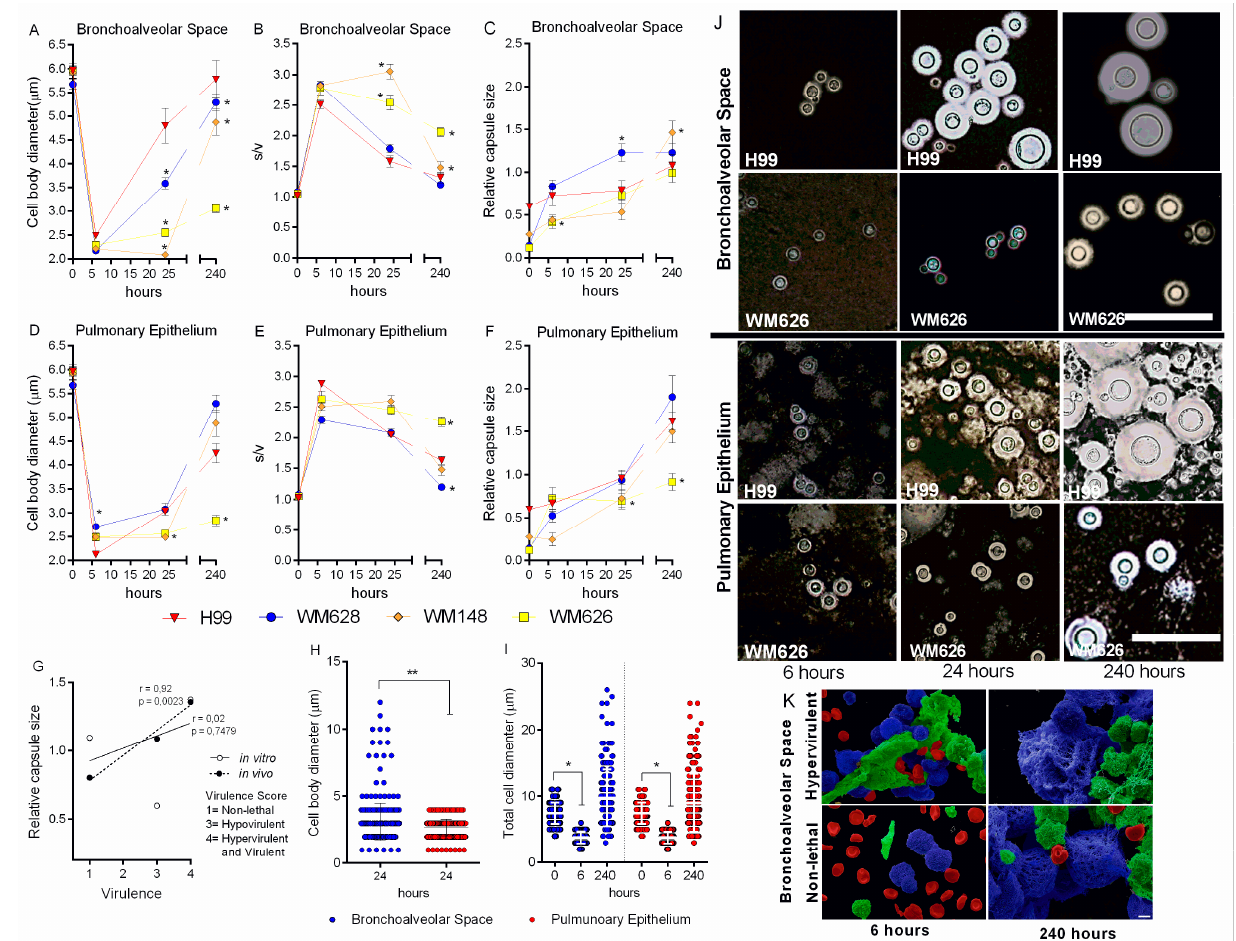
Figure 3. Dynamics of morphological variation of C. neoformans in vivo. ( A – F ) Morphological variation in bronchoalveolar space (BS) and pulmonary epithelium (PE) of four strains of C. neoformans after 6, 24, and 240 h of intratracheal infection. Mean values were compared with H99 (* p < 0.05). ( G ) Correlation between virulence and relative capsule size after 240 h infection. R values are included next to lines of best fit and are based on Pearson correlation. ( H ) Cell body diameter in BS and PE after 24 h of infection. Mean values were compared with bronchoalveolar space (** p < 0.01). ( I ) Total cell diameter in BS and PE after 0 and 240 h infection. Mean values were compared with 0 h of infection (* p < 0.05). ( J ) India ink counter-staining of the yeasts recovered from infected mice. Scale bar: 10 µm. ( K ) Scanning electron microscopy (SEM) of hypervirulent and non-lethal strains after infection: yeasts are colored in blue, bronchoalveolar space cells in green, and blood cells in red. Scale bar: 2 µm. Table 2. Cell body diameter variation in C. neoformans in vivo .